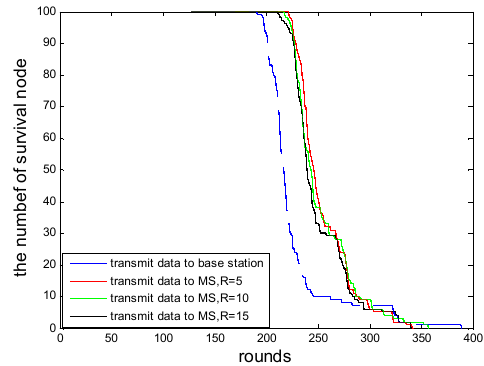
Figure 10. The relationship of stop sites of the MS and the survival time of the network.